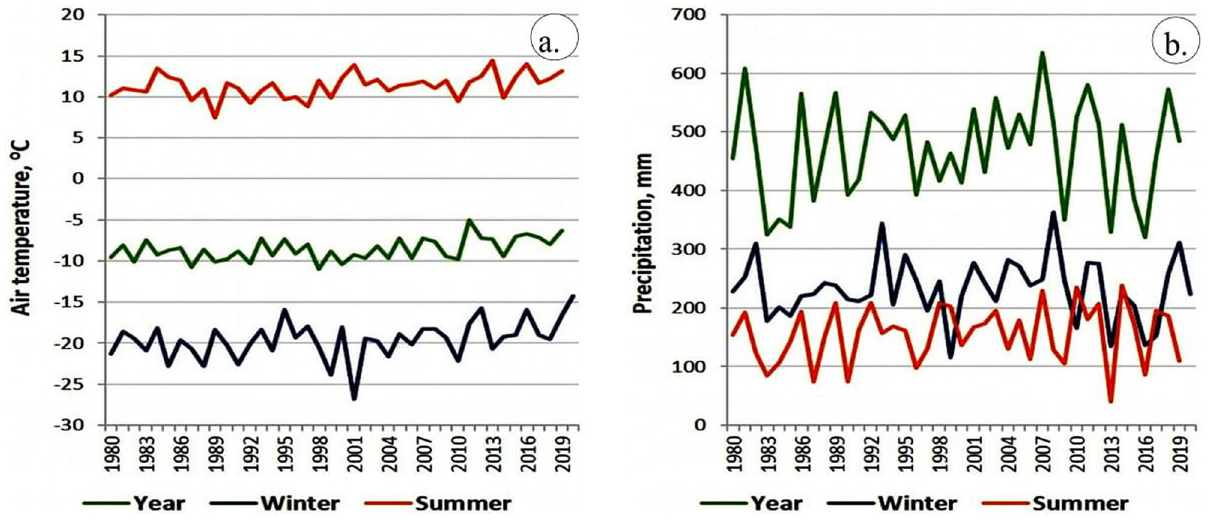
Figure 2. ( a ) Mean annual, winter and summer air temperature and ( b ) precipitation in Norilsk in the period 1980–2020 [Russian Foundation for Basic Research, Project no